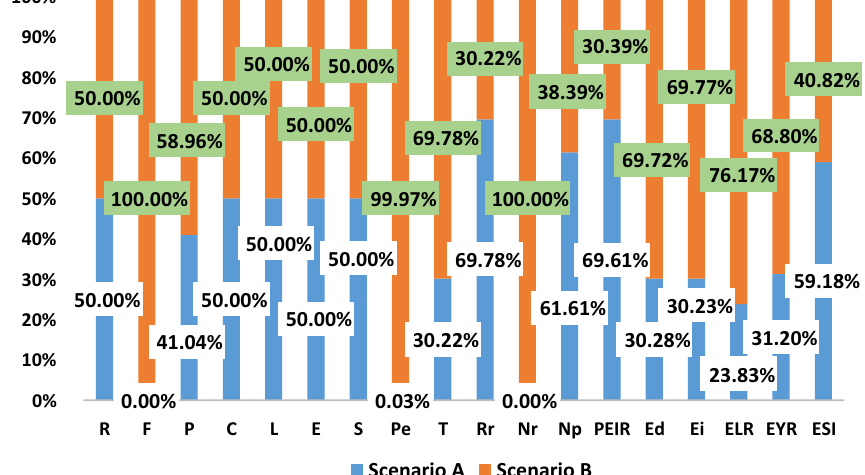
Fig. 5 Indicators comparison between Scenario A and Sce- nario